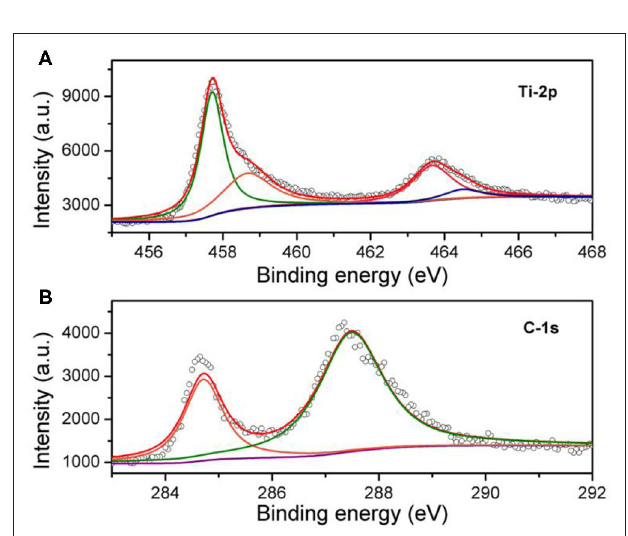
FIGURE 3 | Obtained high-resolution XPS spectra of titanium carbide, TiC 0.7 , synthesized at high pressure and high temperature and previously bombarded by Ar + sputtering for 600s. (A) The Ti-2p 3 / 2 and 2p 1 / 2 spectrum and (B) C-1s